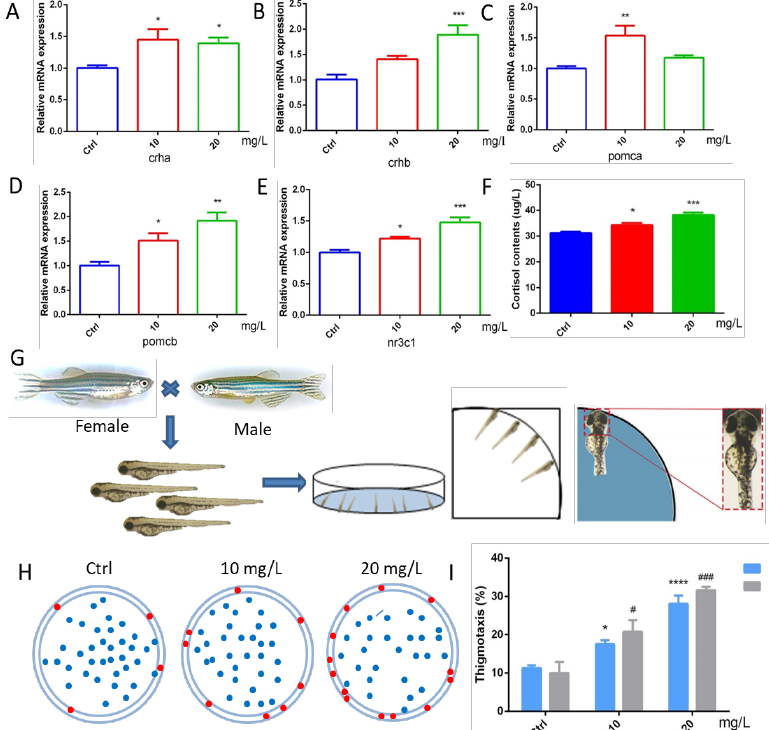
Figure 5. 6-BA treatment affected HPA axis activity and thigmotaxis behavior in zebrafish. ( A – E ) Expression patterns of the HPA axis genes crha ( A ), crhb ( B ), pomca ( C ), pomcb ( D ), and nr3c1 ( E ) in larval zebrafish after 6-BA exposure. ( F ) The effect of 6-BA on HPA axis hormone (cortisol) levels in larval zebrafish. ( G ) Zebrafish exhibited thigmotaxis under 6-BA stimulation, and larvae with only their heads in contact with the petri dish were defined as having positive thigmotaxis. ( H ) Overall distribution of zebrafish larvae in petri dishes under different treatments. Larvae exhibiting thigmotaxis are indicated by red dots on the edge of the petri dish, and the rest are indicated by blue dots. ( I ) Statistics of zebrafish larvae thigmotaxis under different treatments. Values are expressed as mean ± standard error (SEM). N = 3. * p < 0.05, ** p < 0.01, *** p < 0.001, **** p < 0.0001, # p < 0.05, ### p < 0.001.